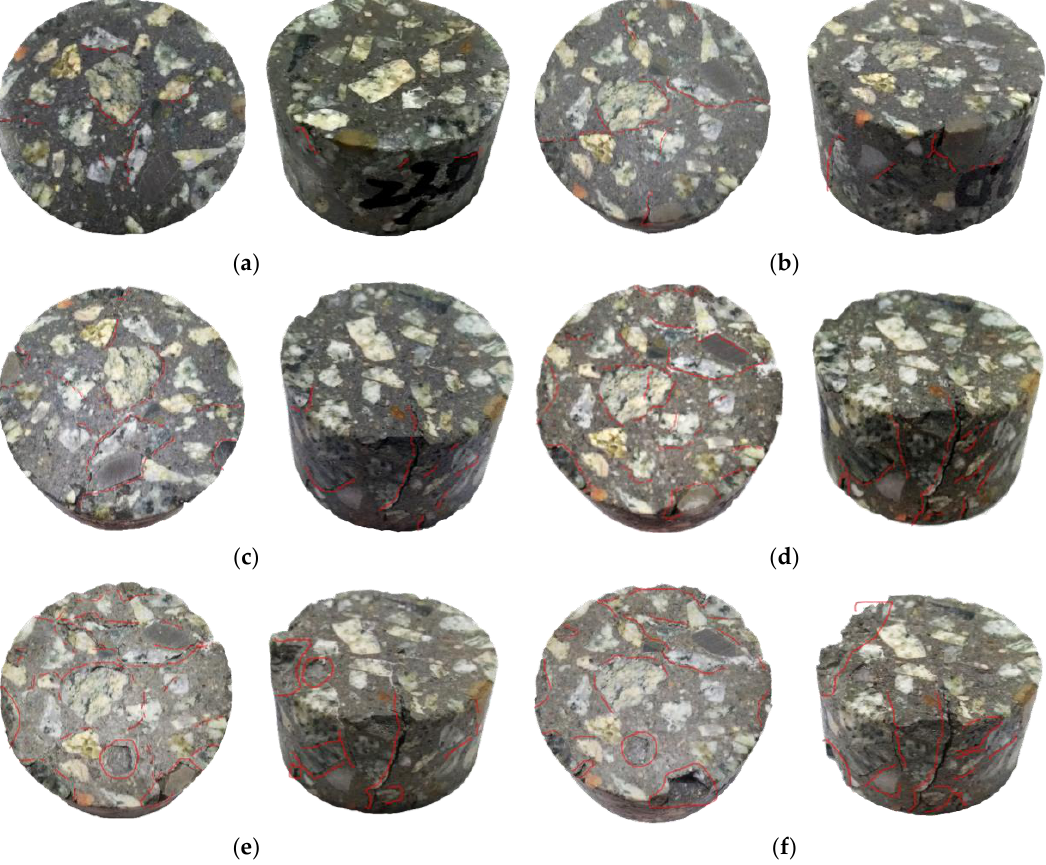
Figure 1. Deterioration characteristics of concrete specimens under freeze-thaw actions. ( a ) 10 freeze-thaw cycles; ( b ) 20 freeze-thaw cycles; ( c ) 30 freeze-thaw cycles; ( d ) 40 freeze-thaw cycles; ( e ) 50 freeze-thaw cycles; ( f ) 60 freeze-thaw cycles.